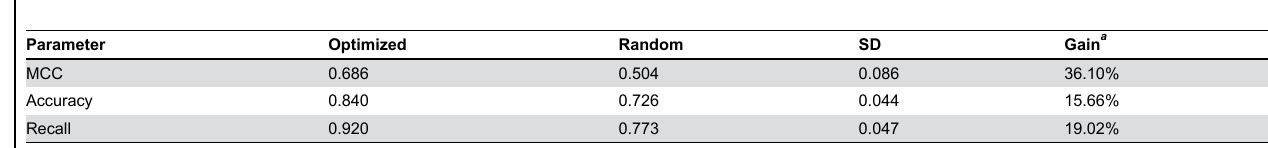
Parameter Accuracy Recall 0.920 19.02% a Percent increase of the value of the optimized statistical parameters compared with random combinations The random values from ten different random linear combinations are averaged.